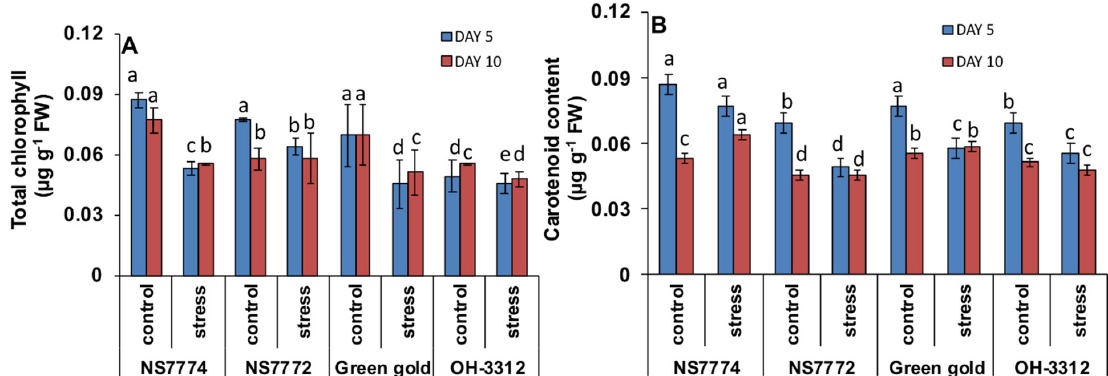
Figure 8. Changes in the photosynthetic pigments: ( A ) total chlorophyll content and ( B ) carotenoid, as affected by drought stress at 5 and 10 days of interval in okra genotypes NS7774, NS7772, Green Gold, and OH3312, along with respective controls. Vertical bars indicate mean ± SE for n = 5. Means denoted by the different letter are significantly different at p ≤ 0.05 according to the Tukey’s studentized range test.